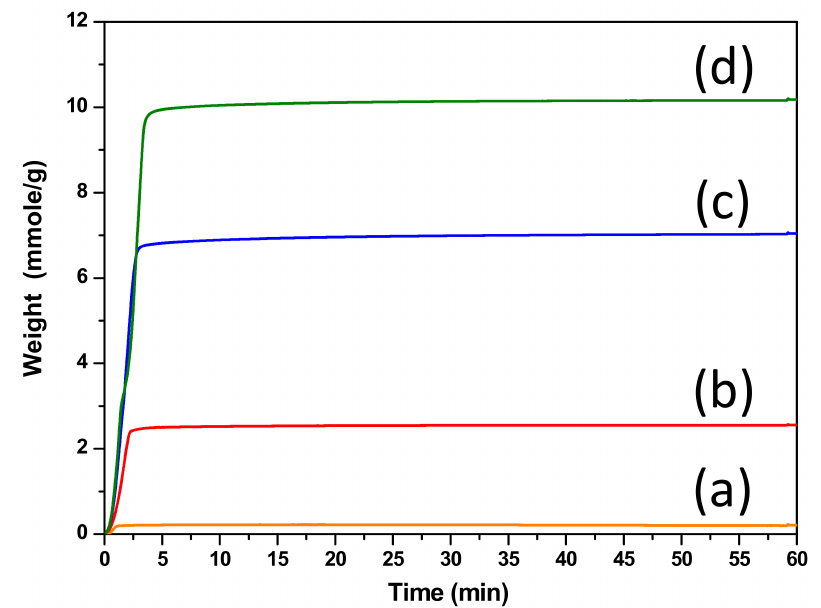
Figure 4. CO 2 capture performance of calcium-based sorbents: ( a ) CaTi-1.2, ( b ) CaTi-2,